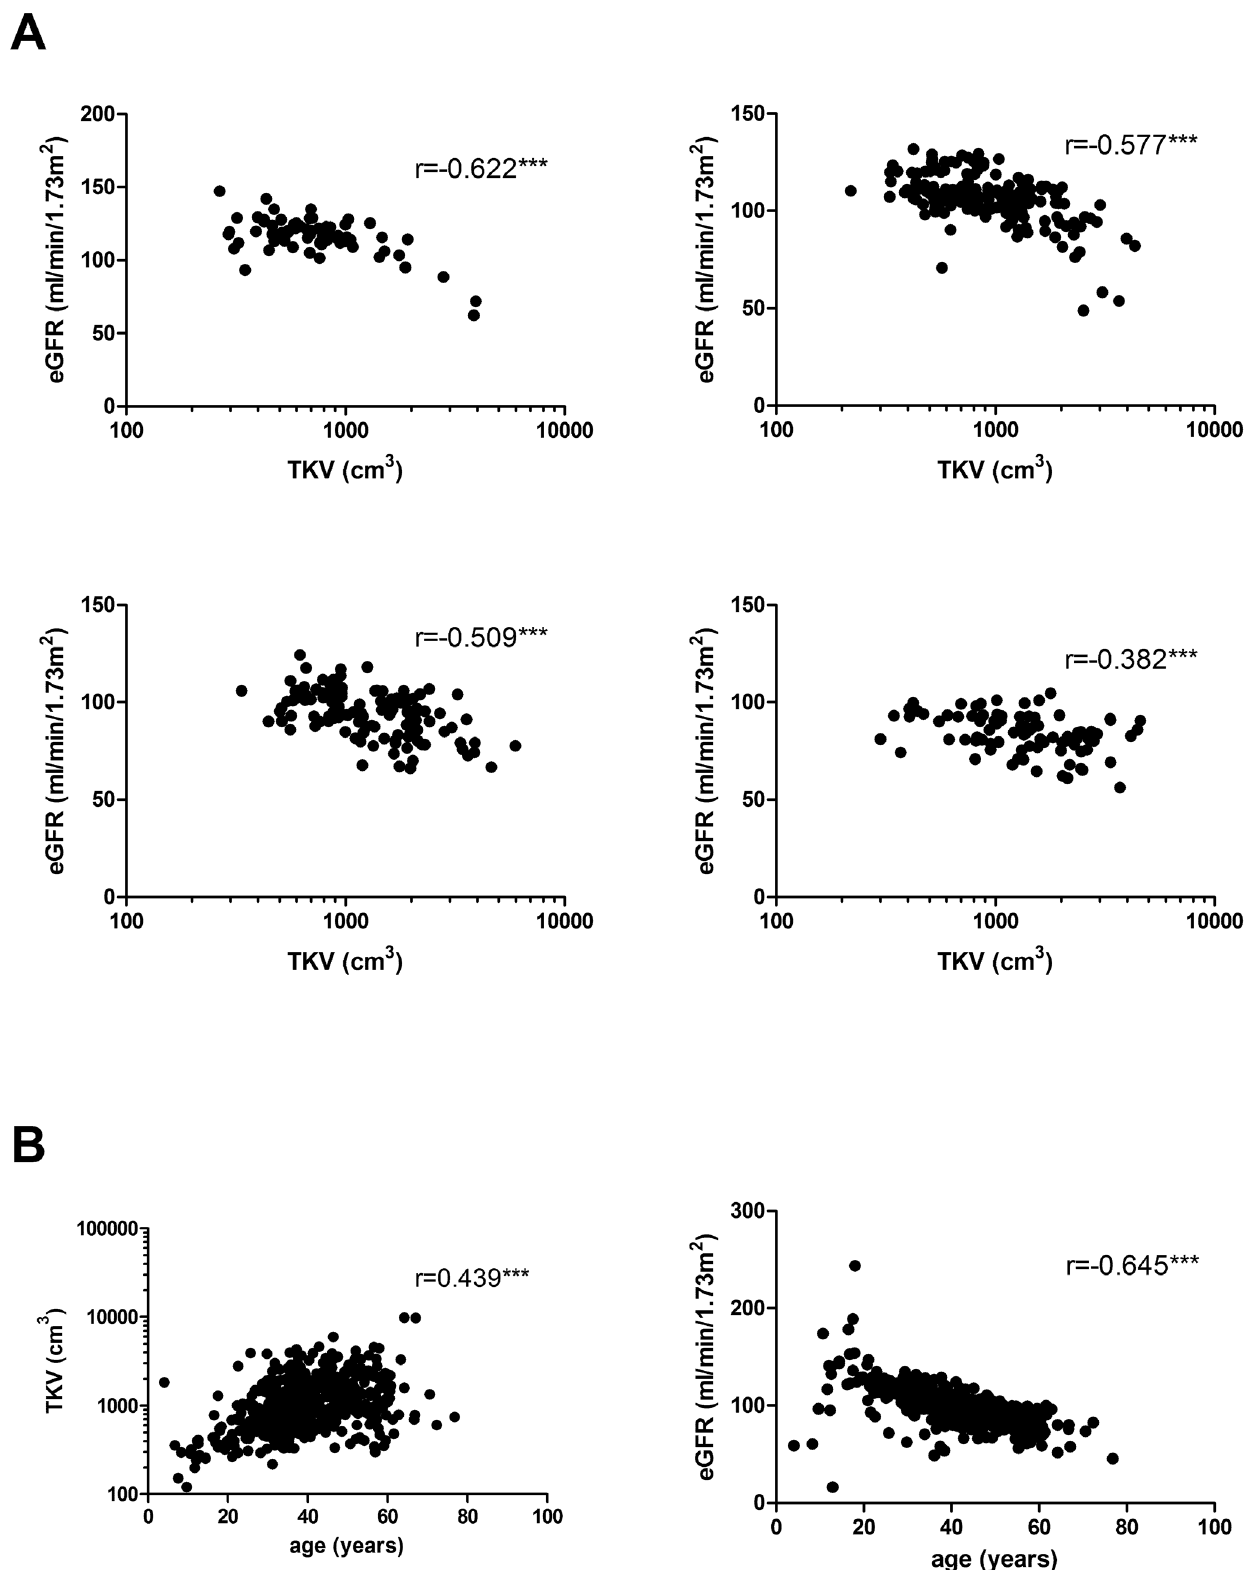
Figure 5. Correlations among TKV, eGFR and age in ADPKD patients. A) Scatter plots between baseline TKV and eGFR. The upper left panel shows patients of age 19–30 years (n=72), the upper right panel patients of age 31–40 years (n=171), the lower left panel patients of age 41–50 years (n=127), and the lower right panel patients of age 51–60 years (n=90). B) Scatter plots between age and baseline TKV (n=532) (left panel), and between age and eGFR (n=502) (right panel). doi:10.1371/journal.pone.0092232.g005 PLOS ONE | www.plosone.org